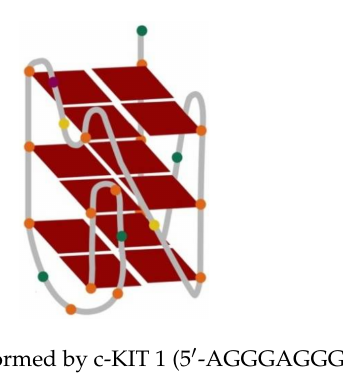
Figure 2. Structure of G-quadruplex formed by c-KIT 1 (5 (cid:48) -AGGGAGGGCGCTGGGAGGAGGG-3 (cid:48) ) [PDB id: 2O3M] [22]. Orange ball = guanine, green ball = adenine, yellow ball = cytosine, purple ball =